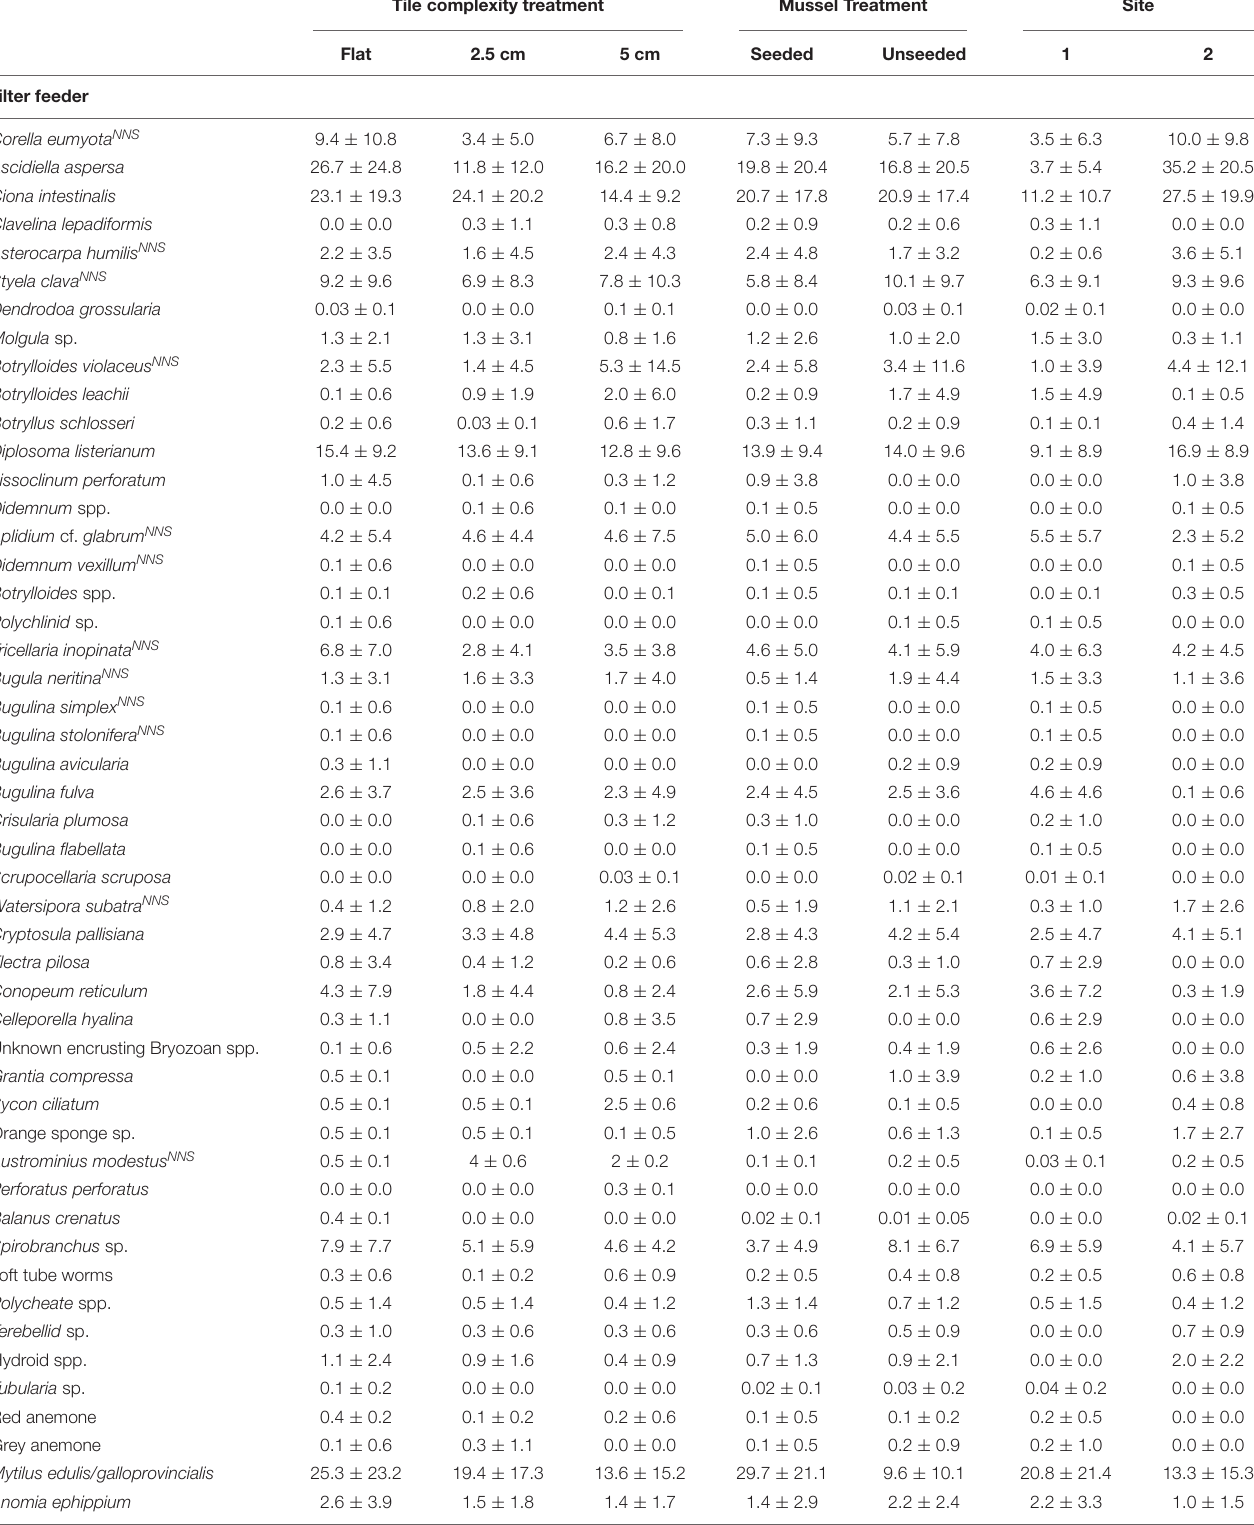
TABLE 2 | Summary table for taxa recorded on subtidal tiles in Plymouth, United Kingdom at the end of 14-month experiments (April 2017–July 2018) testing effects of physical (tile) and biological (mussel) complexity at two sites. Tile complexity treatment Mussel